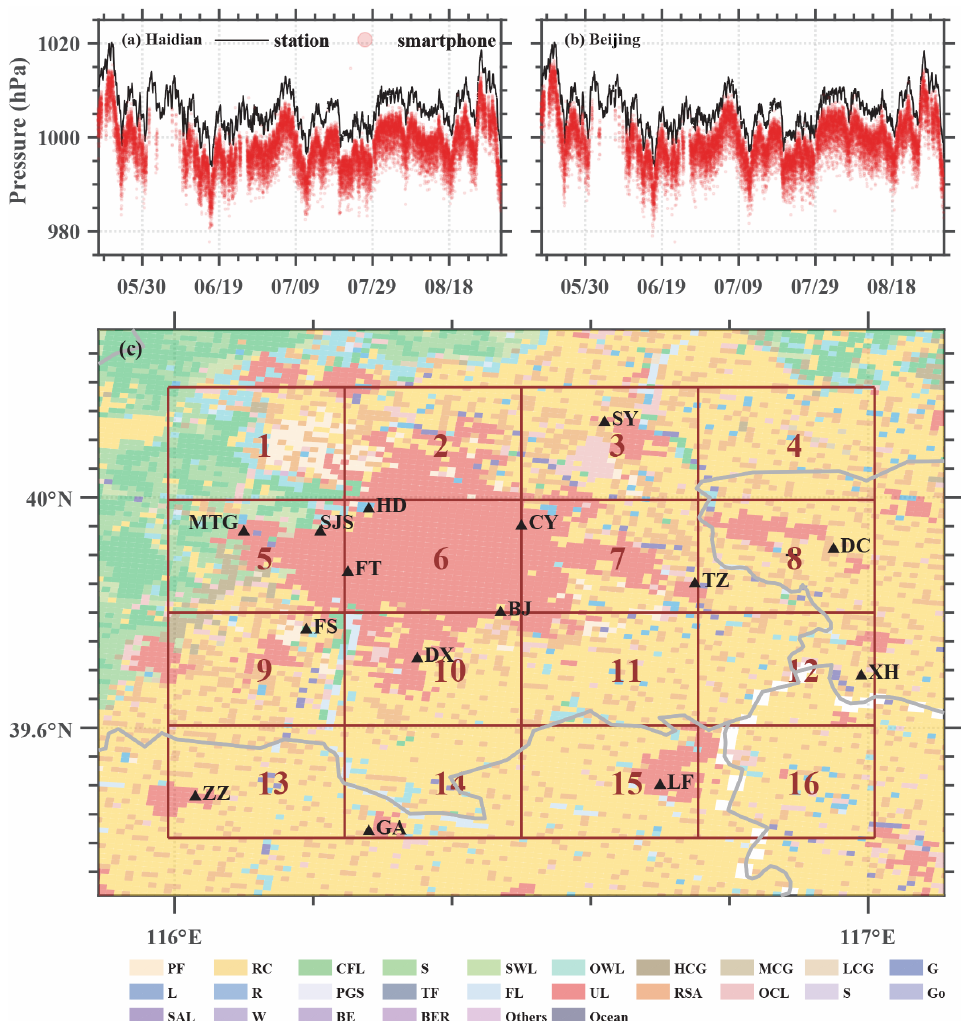
Figure 8. (a, b) Pressure time series during the training period for the AWS (black line) and smartphones (red dots); smartphone pressure was interpolated into station location using the inverse distance weighting method. (c) The domains of the machine-learning area. Shaded areas are regional land use (PF, paddy field; RC, rainfed cropland; CFL, closed forest land; S, shrubbery; SWL, sparse woodland; OWL, open woodlot; HCG, high-coverage grassland; MCG, moderate coverage grassland; LCG, low-coverage grassland; G, graff; L, lake; R, reservoir pond; PGS, permanent glacier snow; TF, tidal flat; FL, flood land; UL, urban land; RSA, rural settlement area; OCL, other construction land; S, sand; Go, Gobi; SAL, saline-alkali land; W, wetland; BE, barren earth; BER, bare exposed rock). Automatic weather stations (AWSs) with pressure observations are shown by black triangles (HD: Haidian; MTG: Mentougou; SJS: Shijingshan; FT: Fengtai; CY: Chaoyang; SY: Shunyi; FS: Fangshan; BJ: Beijing; TZ: Tongzhou; DX: Daxing; DC: Dachang; XH: Xianghe; LF: Langfang; GA: Guan; ZZ: